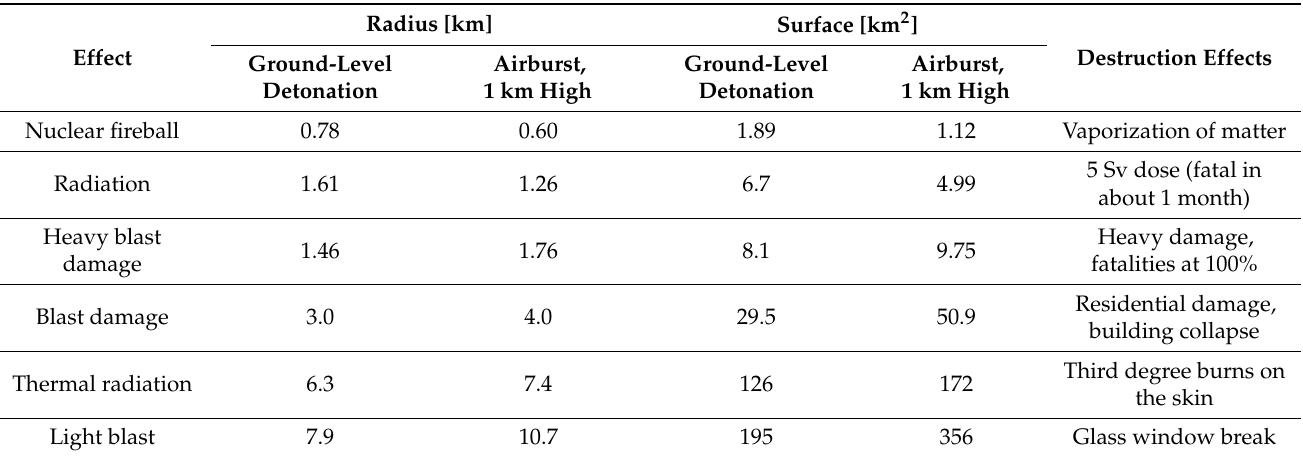
Table 3. A nuclear weapon (0.3 Mt) simulation (second scenario) of effects based on the NukeMap simulator.